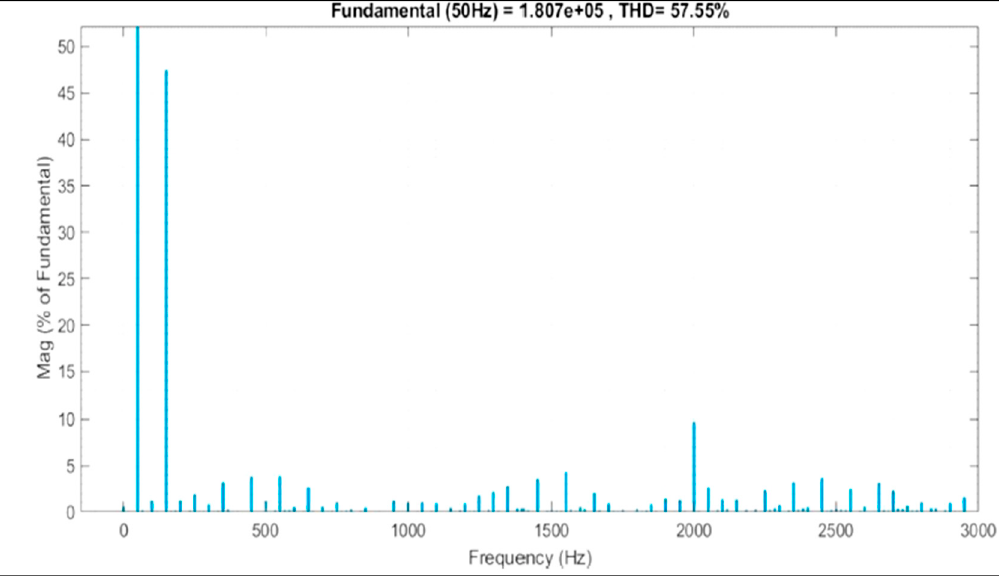
Figure 4. A representation of the harmonic component in the output voltage of the AC side cascaded configuration using 4H-bridges [26].